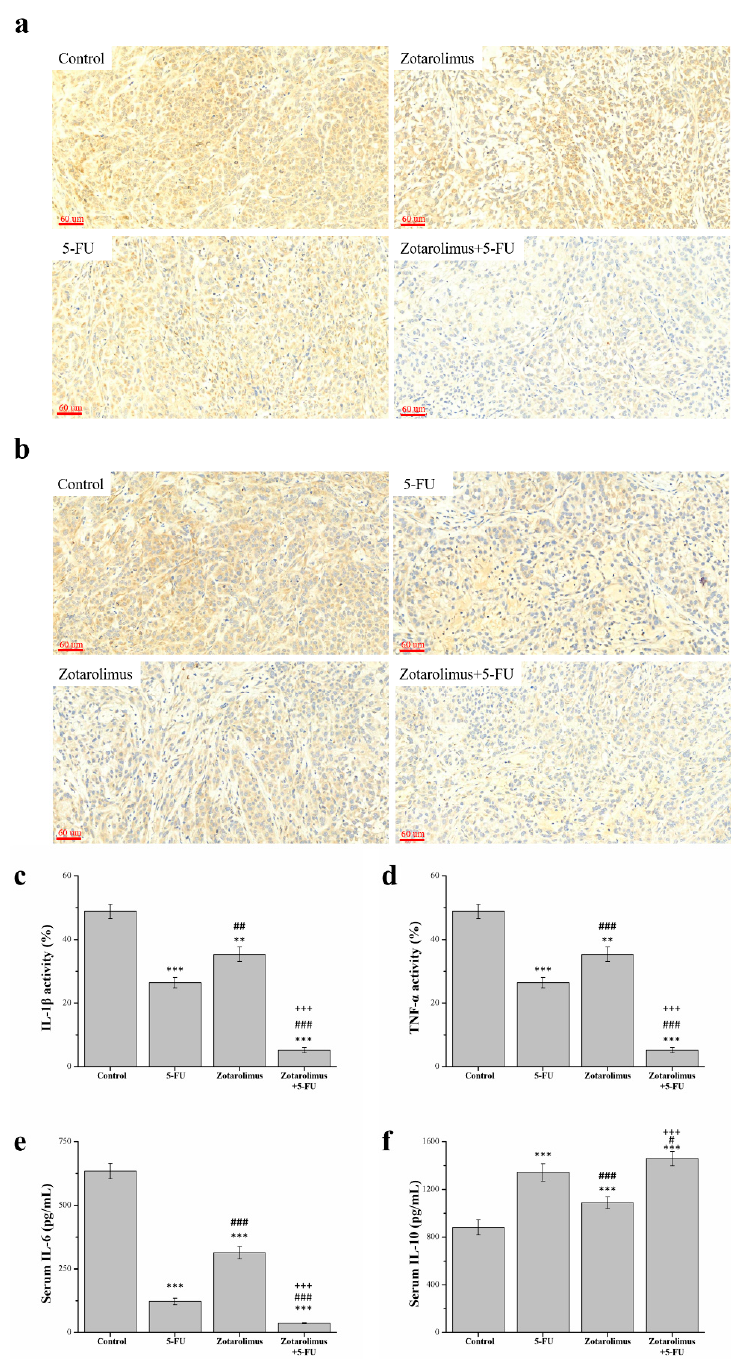
Figure 4. Immunohistochemical expression of ( a ) IL-1 β and ( b ) TNF- α in A549 tumors from BALB/cByJNarl mice and the comparative immunohistochemical expressions of ( c ) IL-1 β and ( d ) TNF- α ; as well as ( e ) IL-6 and (f) IL-10 levels in serum. All experiments were conducted on the A549 tumor masses from BALB/cByJNarl mice. Findings are reported for the control group and treatments: 5-FU (100 mg/kg/week), zotarolimus (2 mg/kg/day), and zotarolimus (2 mg/kg/day) combined with 5-FU (100 mg/kg/week). All data are presented as mean ± standard deviation, n = 7 per group. ** p < 0.01 and *** p < 0.001 compared with the control group. # p < 0.05, ## p < 0.01, and ### p < 0.001 compared with the 5-FU group. +++ p < 0.001 compared with the zotarolimus group. Scale bars = 60 µm.